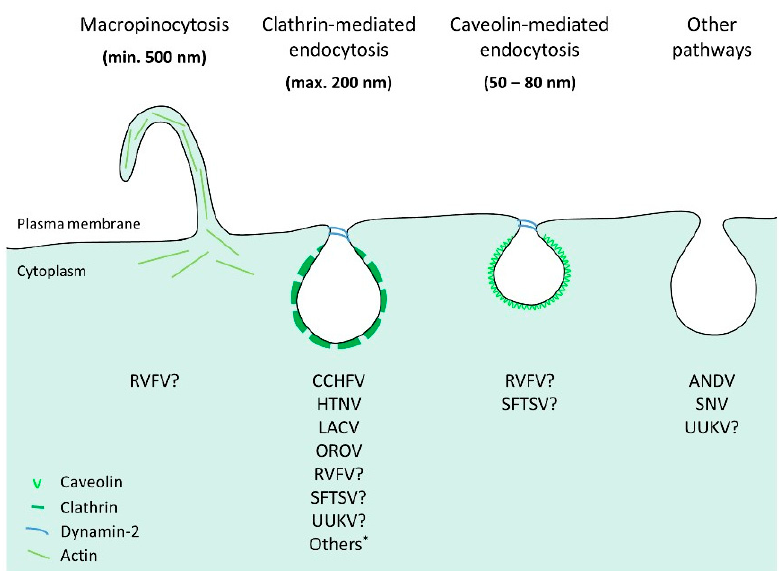
Figure 4. Bunyavirus endocytosis. Endocytic internalization of bunyaviruses into animal cells occurs via various pinocytic pathways, which involve several cellular factors, such as adaptor and coat proteins. A growing body of evidence however indicates that several bunyaviruses use clathrin-mediated endocytosis. * Akabane, Black Creek Canal, California encephalitis, Inkoo, Jamestown, Keystone, Melao, Serra do Navio, Snowshoe Hare, Seoul, Tahyna and Trivittatus viruses. SFTSV: severe fever with thrombocytopenia syndrome virus; UUKV: Uukuniemi virus; RVFV: Rift Valley fever virus; LACV: La Crosse virus; CCHFV: Crimean-Congo hemorrhagic fever virus; ANDV: Andes virus; SNV: Sin Nombre virus; HTNV: Hantaan virus; OROV: Oropouche virus.